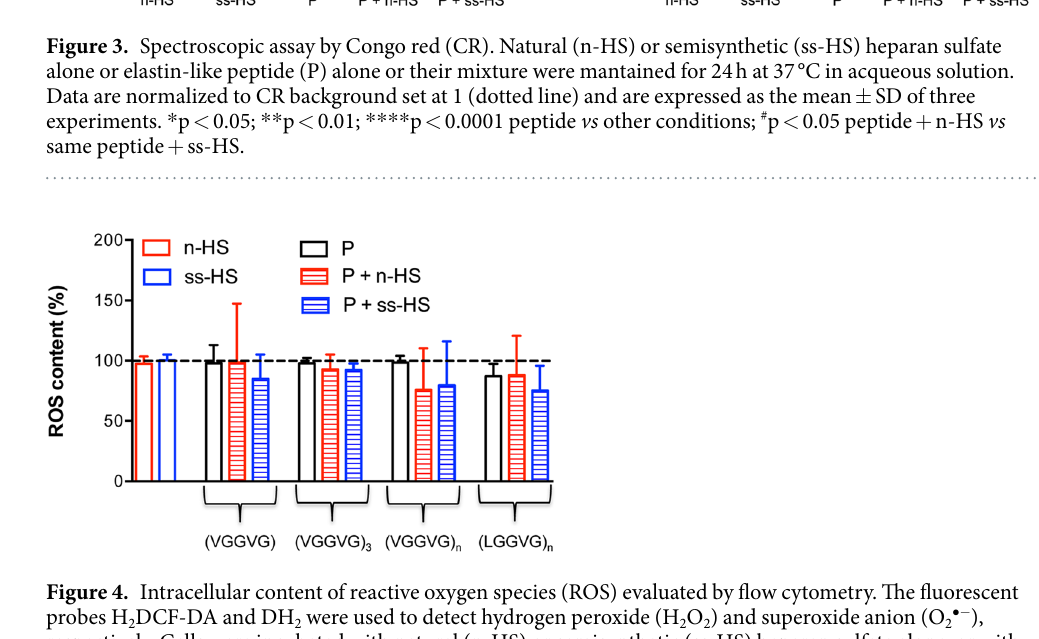
amount of ROS (O 2 •− + H 2 O 2 ) that can be detected in untreated cells was not modified by HSs alone, neither by ELPs alone or supplemented with natural or semisynthetic heparan sulfates (Fig. 4). Adhesion of Balb/c 3T3 fibroblasts is modified on surfaces coated with HSs and ELPs. An adhe- sion assay was performed using Balb/c 3T3 fibroblasts seeded on uncoated or on coated plates. Table 2 shows the percentage of substrate-adherent cells in all experimental conditions compared to the positive control (i.e. cells seeded on tissue culture plates). Results similar to the positive control were noticed only with n-HS and ss-HS alone or with the fibrillar (VGGVG) 3 (Table 2). Cells seeded on plates coated with the other ELP exhibited increased adhesion compared to uncoated surfaces, but cell adhesion in these experimental conditions was always reduced compared to the positive control or to HS-coated surfaces. Cell adhesion on surfaces coated with all ELPs + ss-HS was significantly reduced in comparison with ELP alone and/or HS alone (Table 2 and Supplementary Fig. S5). In the case of ELP + n-HS (Table 2 and Supplementary Fig. S5), the effects seemed dependent on the type of ELP. In particular, (VGGVG) n + n-HS did not significantly modify the number of adherent cells compared to fibrillar ELP alone. Adhesion on coated sur- faces with (VGGVG), (VGGVG) 3 , and (LGGVG) n + n-HS was further reduced in comparison with ELP alone.